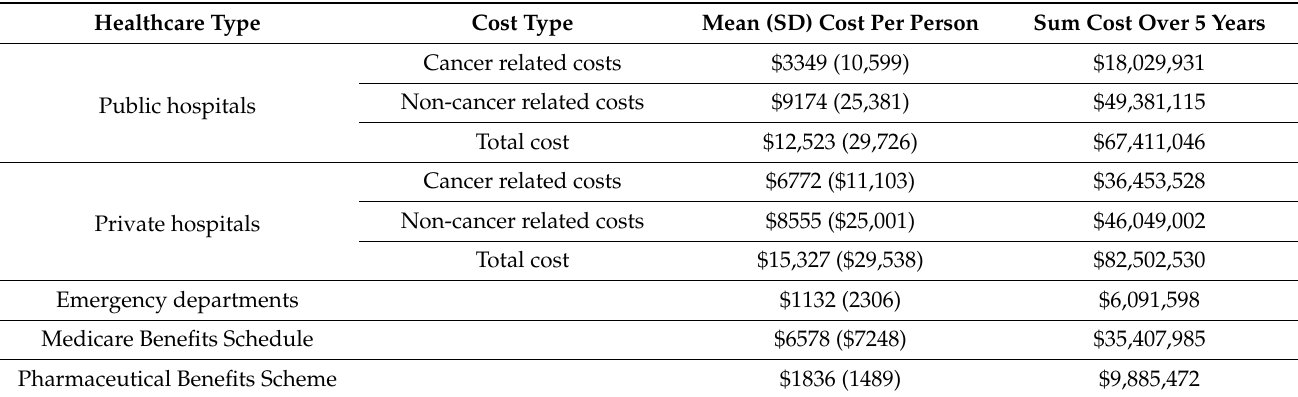
Table 2. Healthcare costs over five years for Queensland women with breast cancer diagnosed between 1 July 2011 and 30 June 2013.